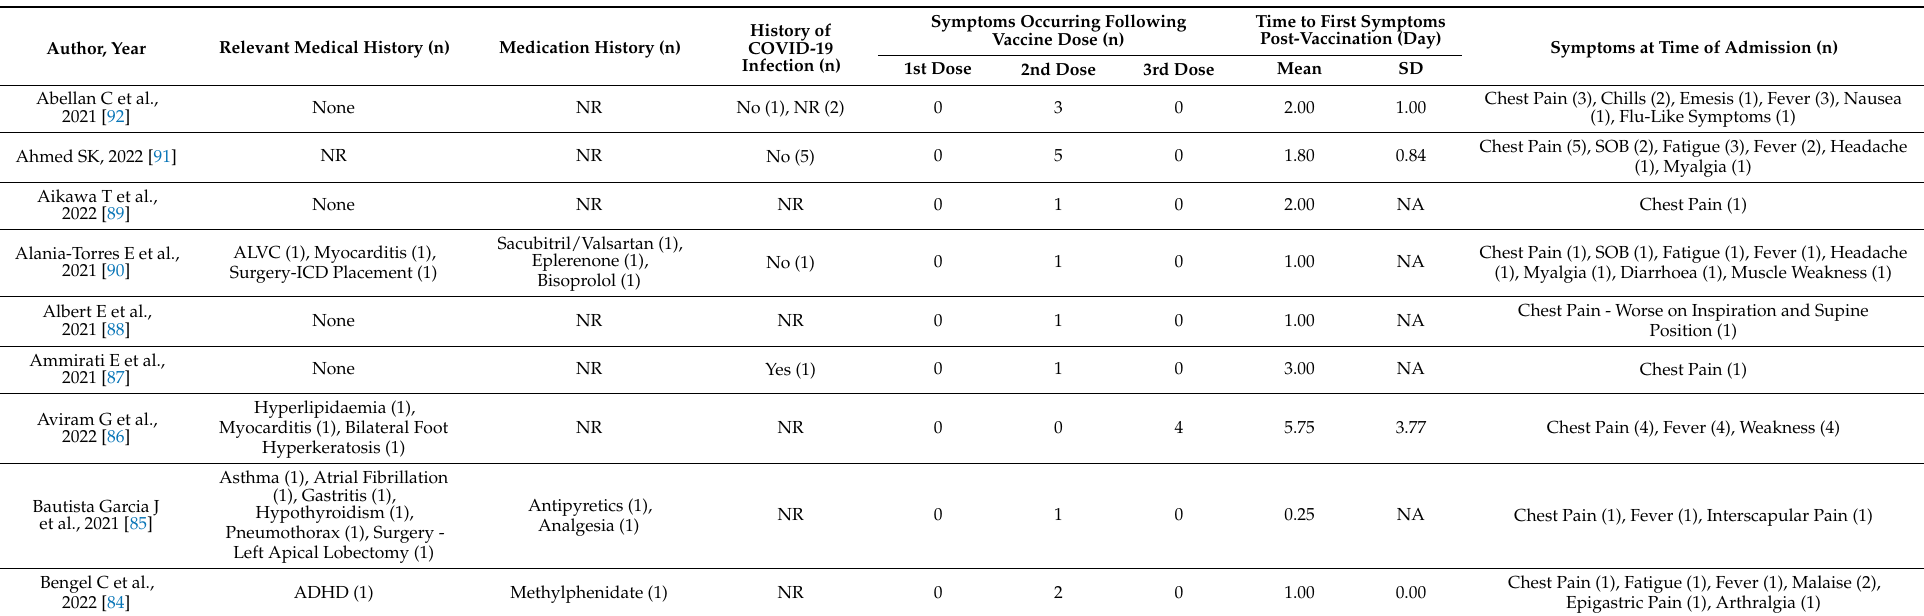
Table 2. Clinical Characteristics of Included Patients